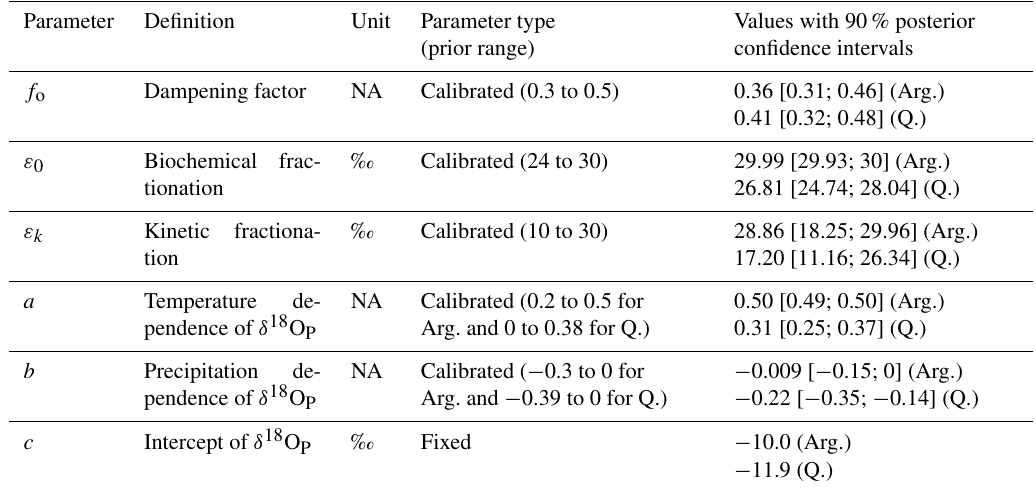
Table 1. Definition of sensitive parameters. The posterior medians and 90% confidence intervals are also shown. Arg.: Argentina; Q.: